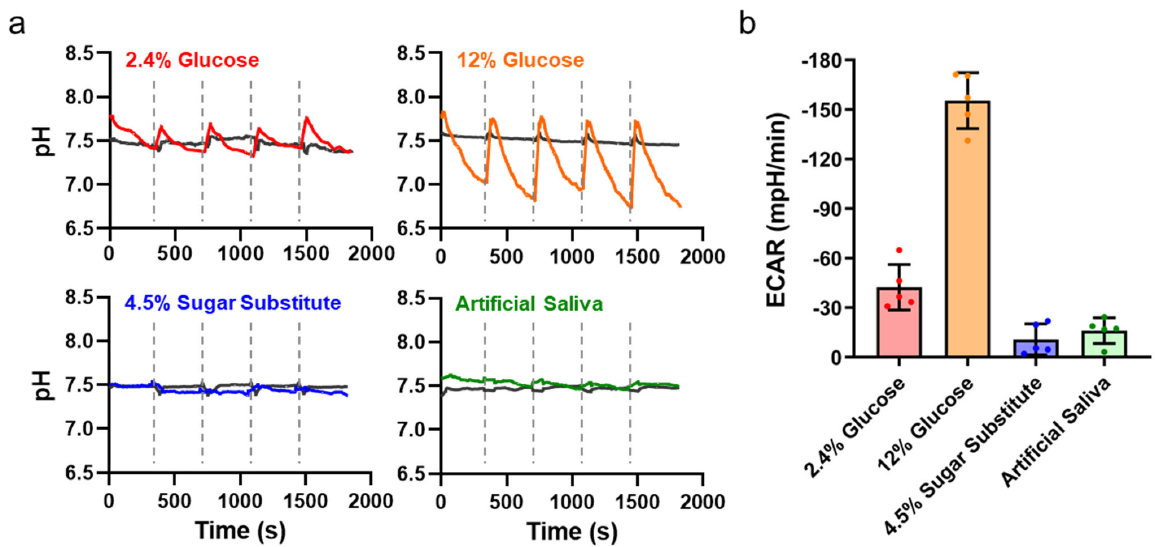
Figure 6. The pH change and ECAR values of sweetener metabolism of Lactobacillus rhamnosus . ( a ) The pH changed with time, and a fresh medium was injected every 360s; the 2.4% ( w / v ) glucose solution, the 12% ( w / v ) glucose solution, the 4.5% ( w / v ) sugar substitute solution and artificial saliva were injected successively. ( b ) The average ECAR values of different sweetener solutions and artificial saliva.